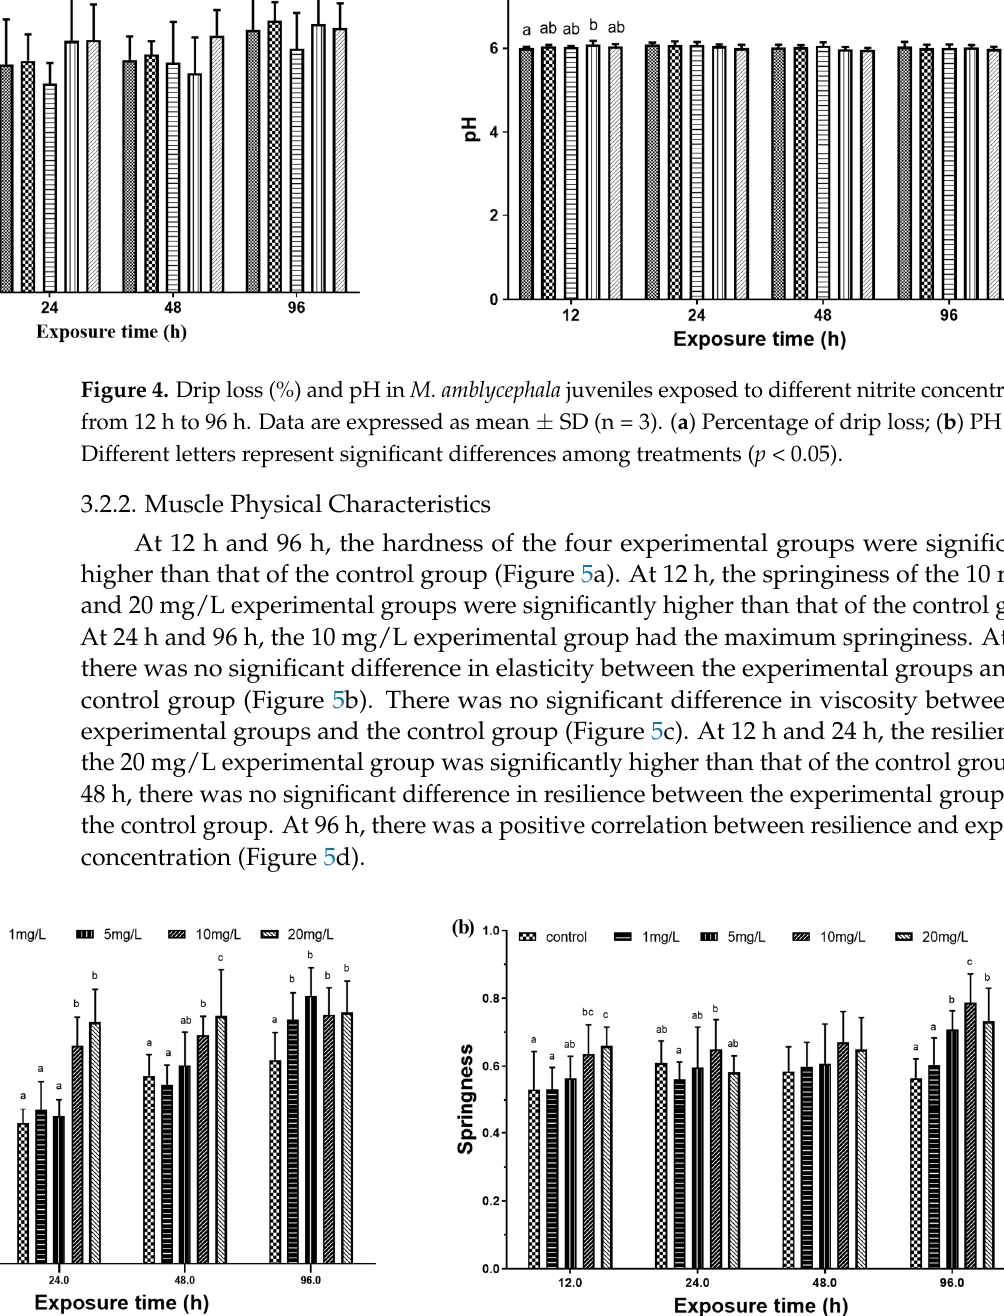
Figure 5. Muscle texture characteristics of M. amblycephala juveniles exposed to different nitrite con- centrations from 12 h to 96 h. Data are expressed as mean ± SD (n = 3). ( a ) Hardness value; ( b ) springiness value; ( c ) cohesiveness value; ( d ) resilience value. Different letters represent significant differences among treatments ( p < 0.05). 4. Discussion 4.1. The Effect of Nitrite on Serum Biochemical Indices The triggering of fish anti-stress mechanism is mainly through the stress of fish reg- ulating the central hypothalamus–pituitary–renal tissue axis (HPI), releasing adrenocor- ticotropic hormone (ACTH), and promoting stress hormones such as catecholamines and cortisol in the fish body [27]. The synthesis and release of the stress hormones induce stress response in the fish body, which can promote protein, fat, and carbohydrate metab- olism by regulating various physiological and biochemical reaction processes of the body. In addition, as an oxidant, nitrite also triggers the activation of the protective effect of the fish body’s antioxidant system, which triggers changes in the activity of enzymes includ- ing SOD, CAT, and GPx [18]. As a direct energy supply substance, blood glucose can maintain the internal envi- ronment stability under environmental stress and improve the energy security of osmotic regulation and material metabolism [28]. This experiment found that nitrite stress can lead to a significant increase in serum cortisol concentration. At 12 h, the serum cortisol